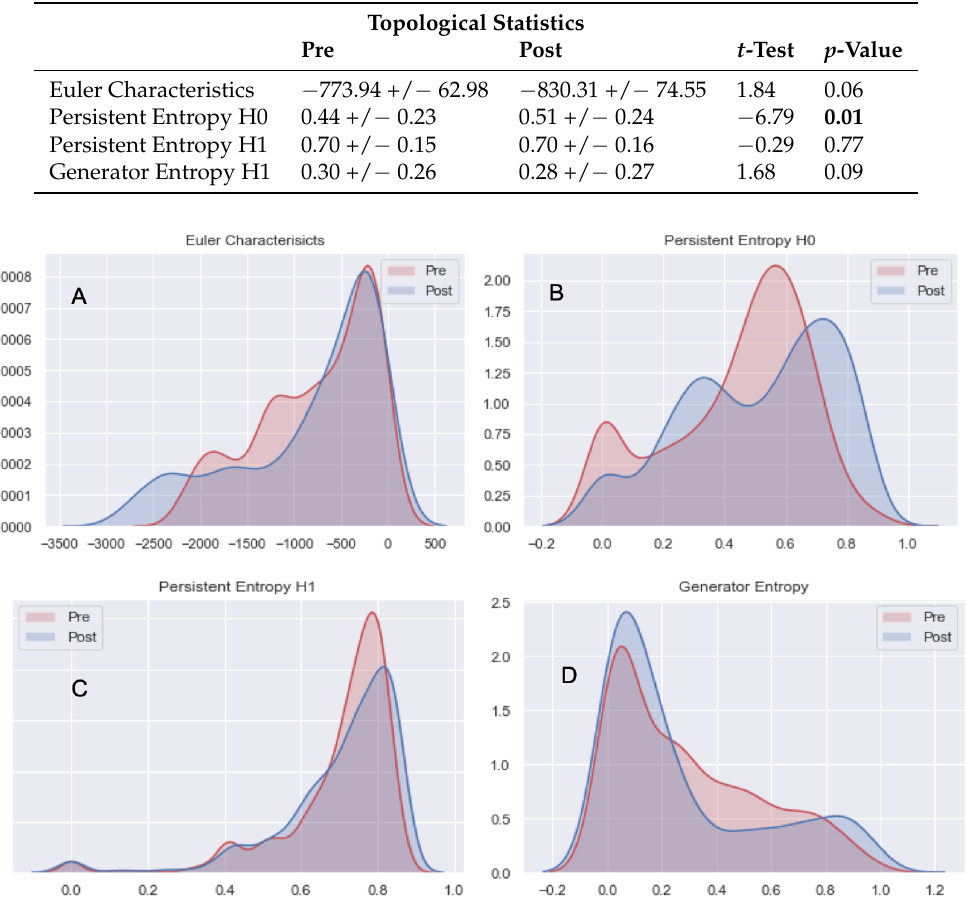
Figure 12. Density estimation for the topological features: comparison between the features computed on the “pre” and on the “post” set of 2D FLAIR. ( A ) Euler Characteristics, ( B ) Persistent Entropy H0, ( C ) Persistent Entropy H1, and ( D ) Generator Entropy